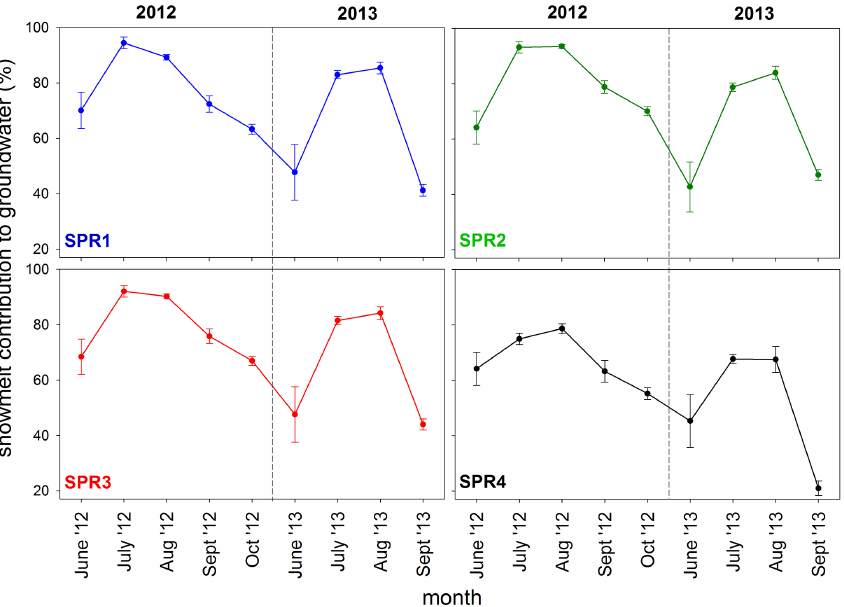
Figure 10. Snowmelt contribution to groundwater recharge based on δ 2 H data for different sampling times in 2012 and 2013. The error bars indicate the ± uncertainty at 70%.